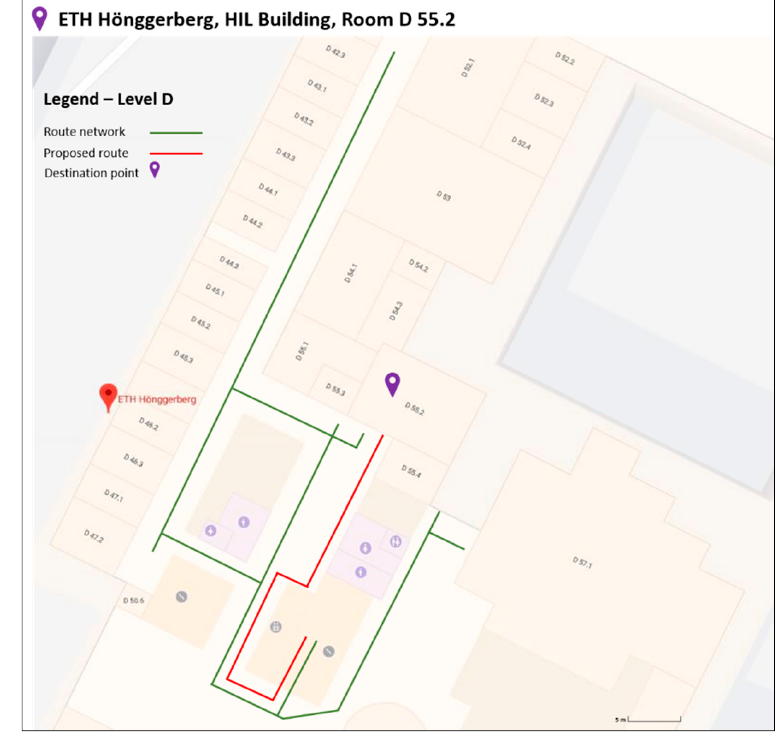
Figure 3. Destination point (room D 55.2) and routing path on D floor.